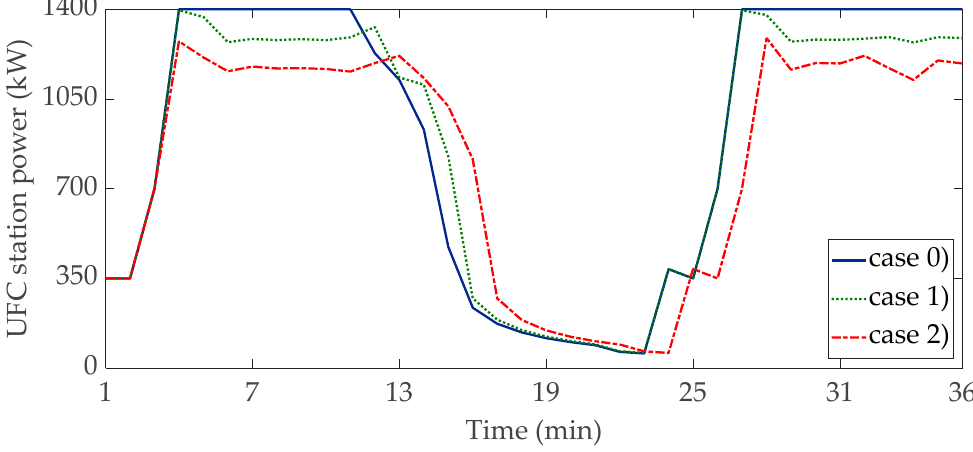
Figure 9. Power profile of the UFC station at bus #12 (UFCS 3 ) in the three case studies. Compared to the ideal case ( case (0) ), the reduction of the power absorbed from the microgrid in the cases (1) and (2) clearly appears. In case (2) , the reduction of the absorbed power is greater than that in case (1) . In agreement with the results of Table 3, the longer charging time of case (2) is more apparent and can be well appreciated in Figure 9, and the smaller difference in the charging times of cases (0) and (1) is also clear. In Figure 10 the powers absorbed by all PEVs plugged-in at the UFCS3 during the considered period are reported with respect to the three case studies. The corresponding SoC profiles are reported in Figure 11. By comparing the profiles of case (1) and ( 2) with those of case (0) , in Figures 10 and 11, the ability of the proposed approach to properly manage the power of the vehicles to meet the vehicle constraints is evident.